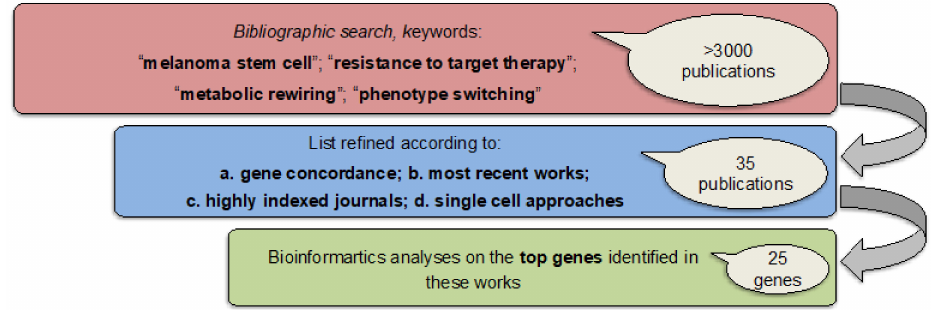
Figure 1. Schematic workflow of the study divided into three steps to obtain a list of 25 top genes for bioinformatics analyses.